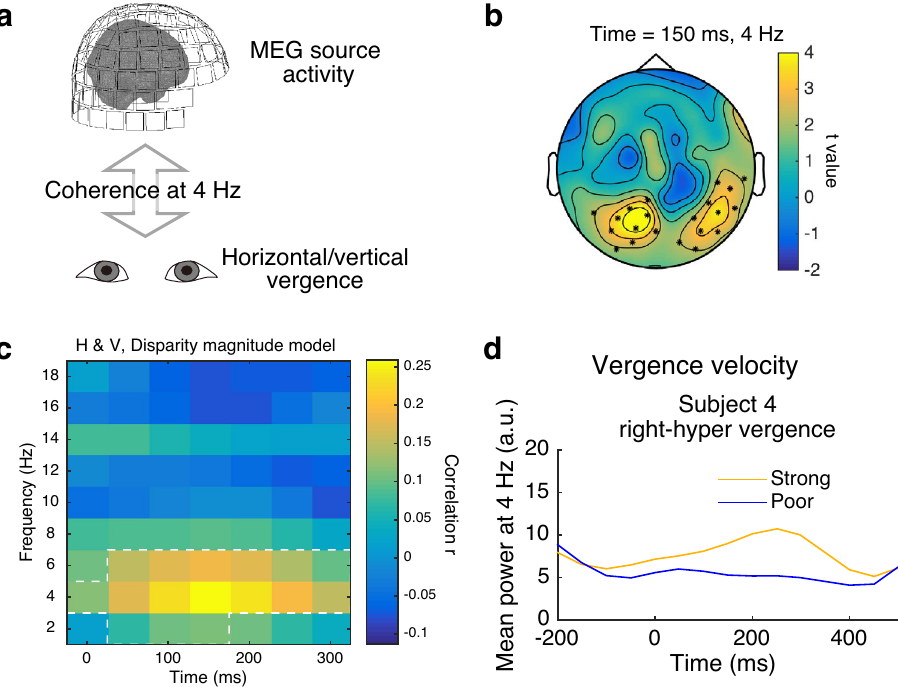
Figure 4. Brain-ocular coherence analysis. ( a ) Schematic illustration of brain-ocular coherence. ( b ) Induced power change associated with disparity magnitude found in occipital sensors. Asterisks indicate significant sensors revealed by a cluster-based permutation test. ( c ) Mean correlations calculated for the asterisked sensors in (b). The white dotted region indicates the significant combination of time and frequency. ( d ) Sample of vergence velocity power for the stimulus-vergence interaction